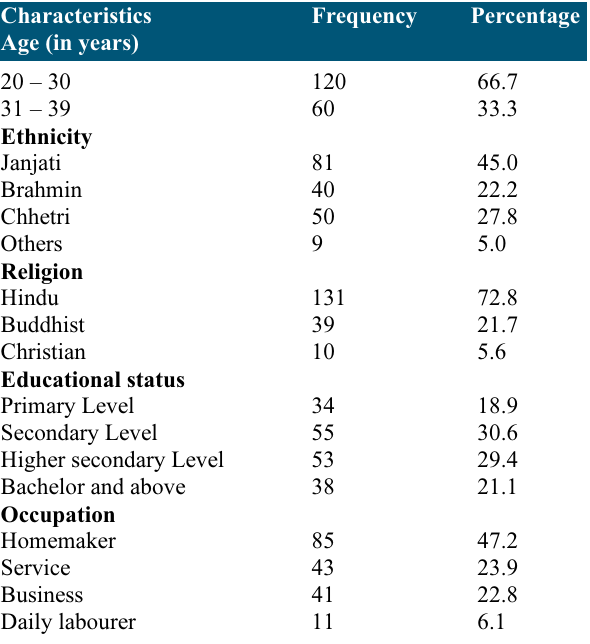
Table 2: Obstetric characteristics of the